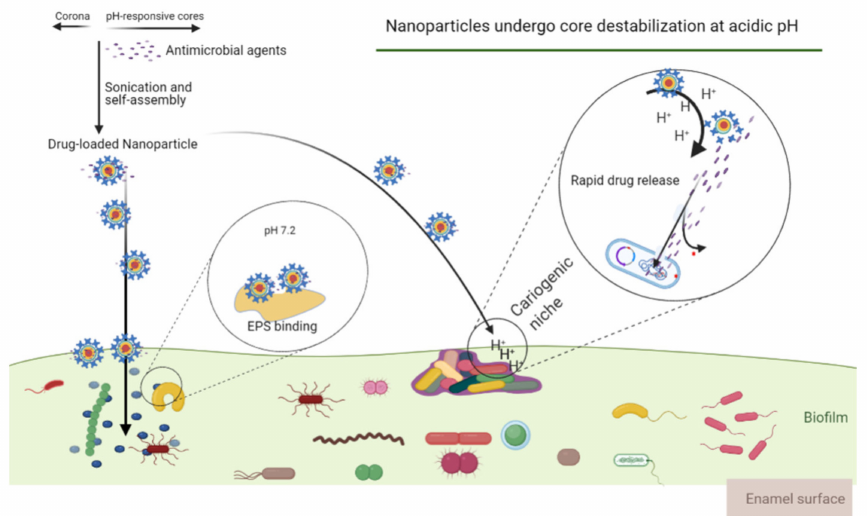
Figure 3. pH-triggered release of nanoparticles and their effect on cariogenic biofilm.